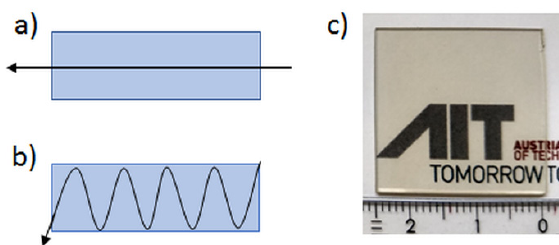
Figure 6. ( a ) Spraying pattern used in first experiments, ( b ) optimized spraying pattern, and ( c ) image of glass/IZO films with the optimized spraying protocol.